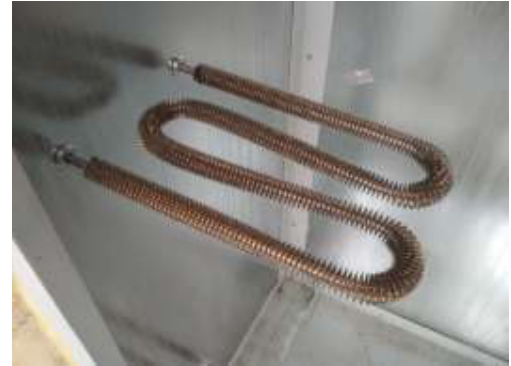
Fig. 6. Simulation heat source – resistive